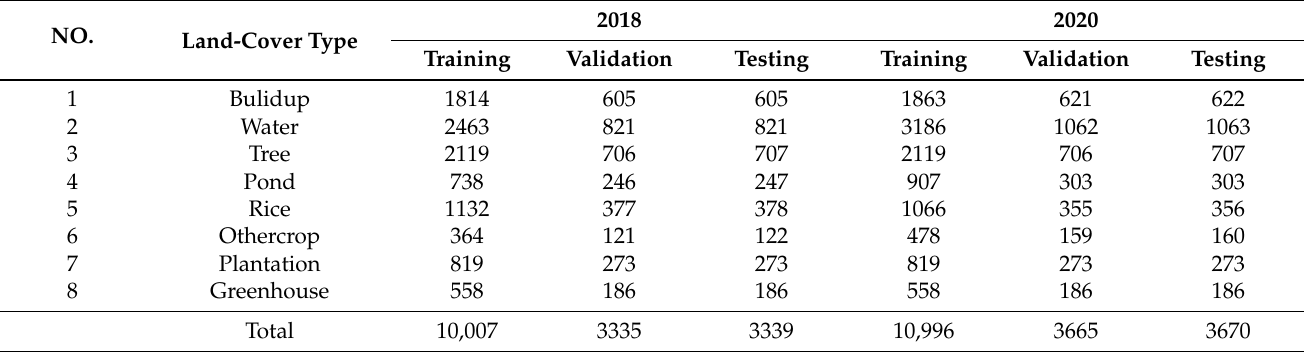
Table 10. Sample size of dataset in Changxing County in 2018 and 2020.